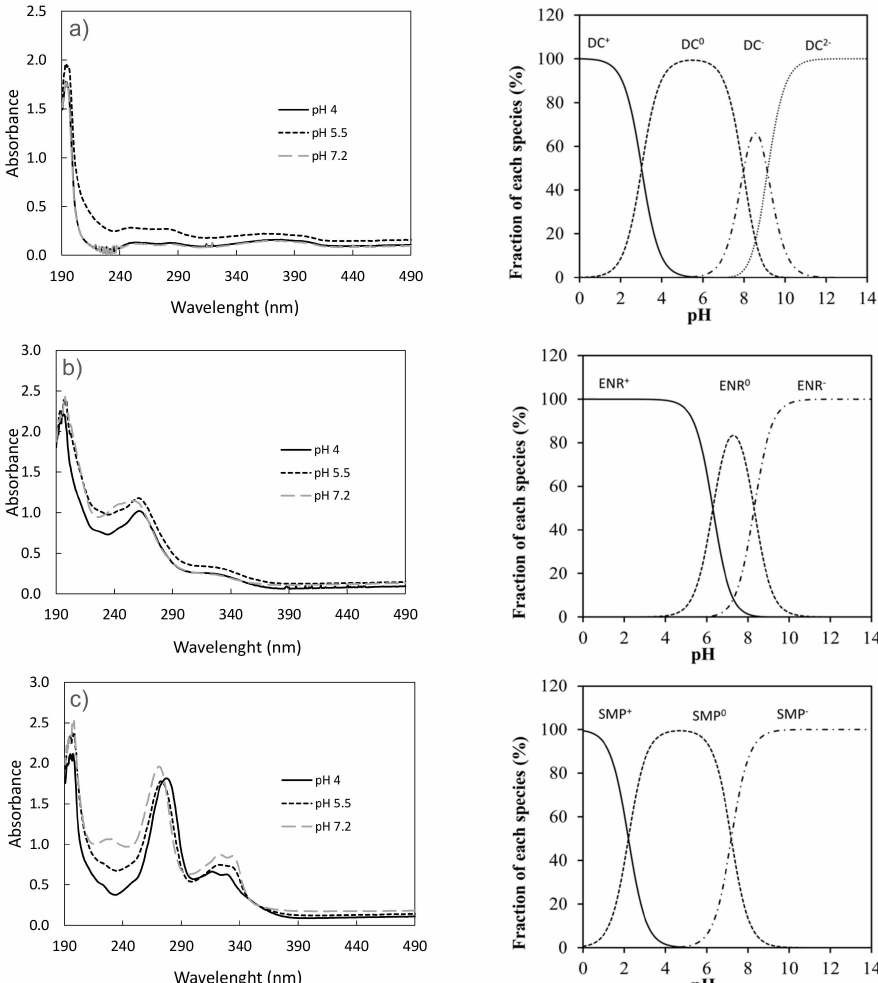
Figure 2. Antibiotic absorption spectra and speciation at different pHs (4.0, 5.5, and 7.2). ( a ) Doxy- cycline (DC) spectrum and DC speciation; ( b ) Enrofloxacin (ENR) spectrum and ENR speciation; ( c ) Sulfamethoxypyridazine (SMP) spectrum and SMP